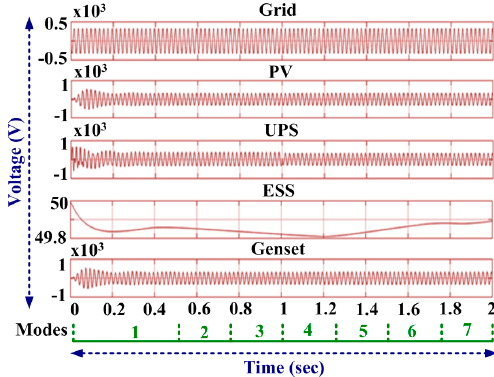
Figure 10. Output voltage of (top to bottom: grid, PV, UPS, ESS, and genset).